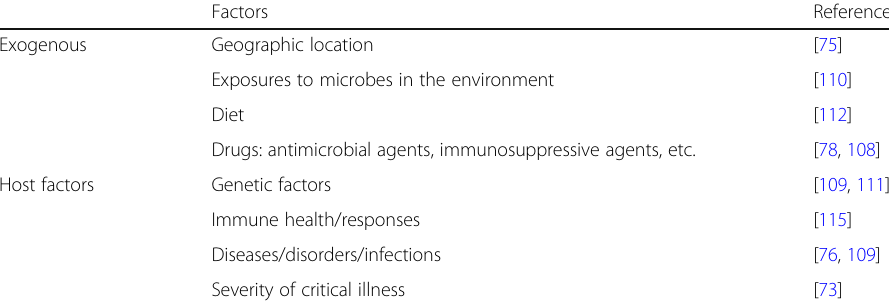
Table 1 Factors contributing to the development of gut